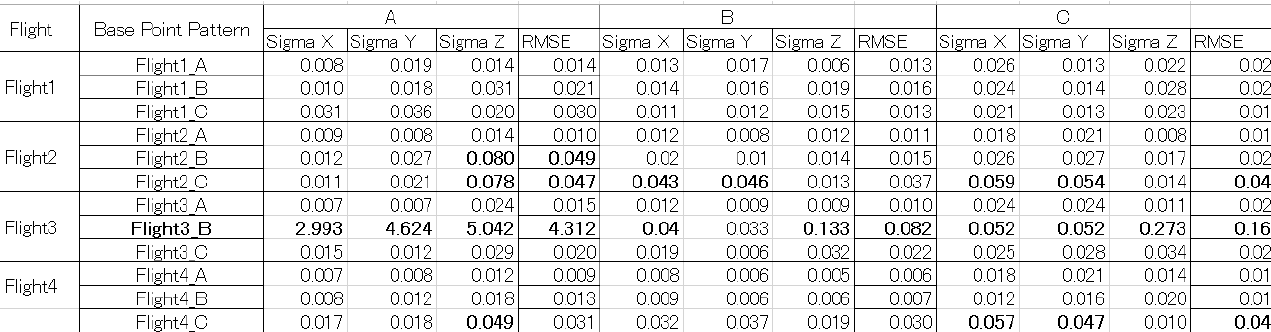
Table 9. Accuracy in the distribution of control points (unit m)